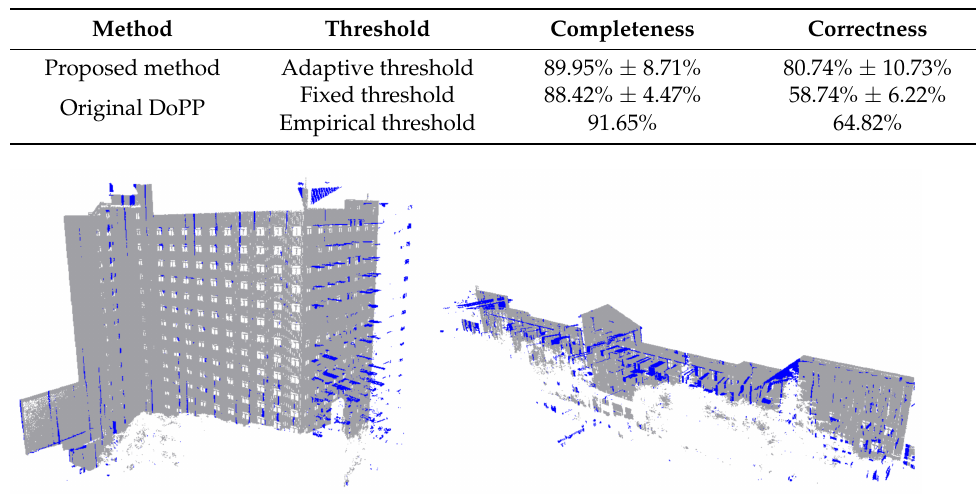
Table 2. Comparison of the proposed and original DoPP filtering. For the two methods, 200 and 300 groups of parameters are generated respectively. The corresponding results are in the form of mean ± standard deviation of all runs. The empirical parameter of the original DoPP filtering is set according to [24,57].